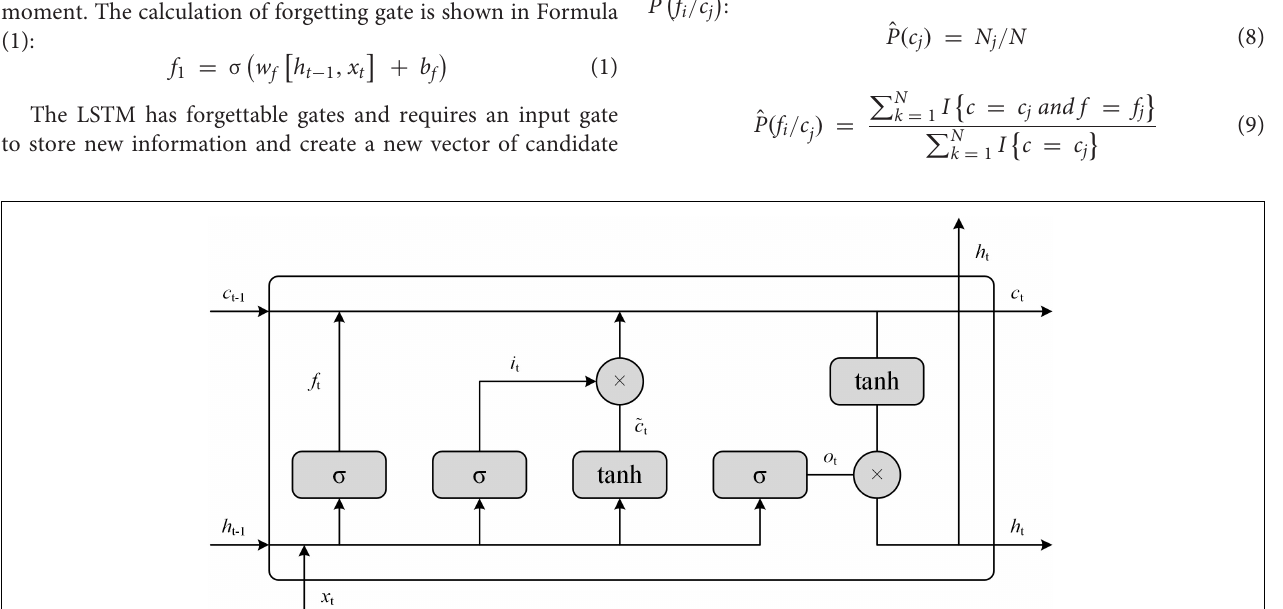
FIGURE 4 | The Long Short-Term Memory (LSTM) model of semantic recognition